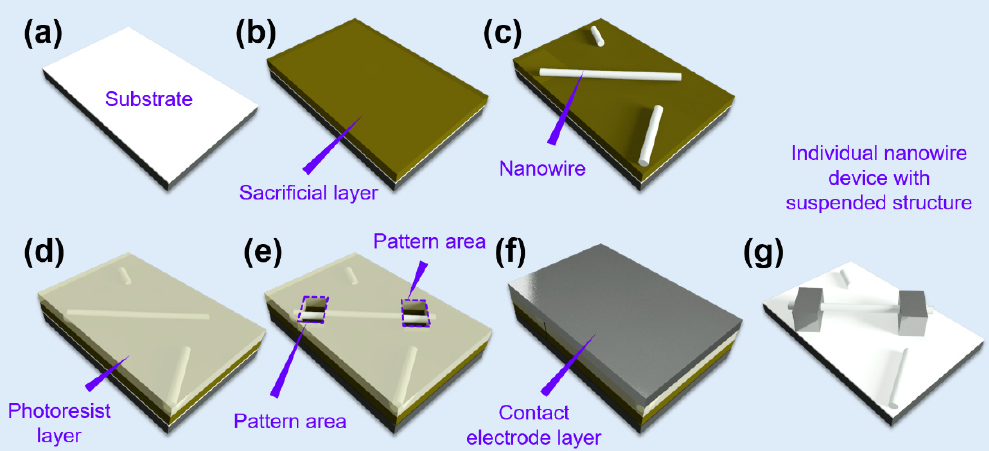
Figure 13. A schematic diagram of the individual suspended nanowire device fabrication process: ( a ) substrate; ( b ) photoresist coating (sacrificial layer); ( c ) transferring nanowires onto the substrate; ( d ) photoresist coating (sacrificial layer); ( e ) sacrificial layer patterning; ( f ) contact electrode deposition; and ( g ) individual nanowire device with suspended structure after the lift-off process.